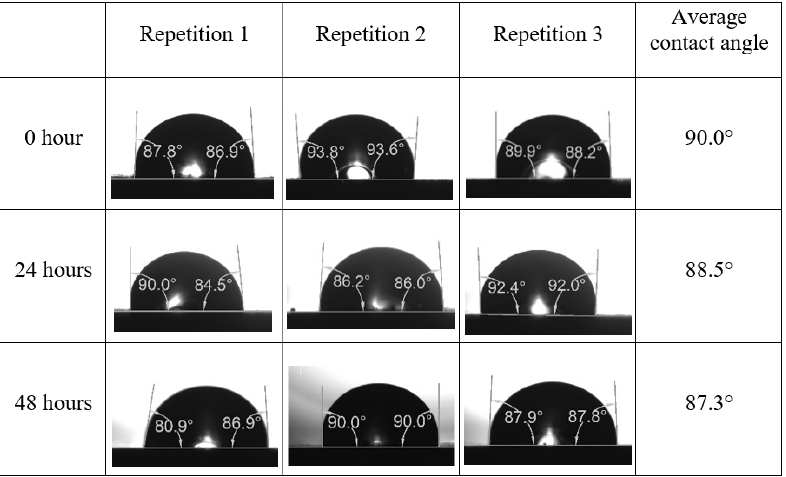
Figure A6. Dynamic Contact Angle Measurement Results for 50% MgCl 2 + 50% KCl (3500 ppm).